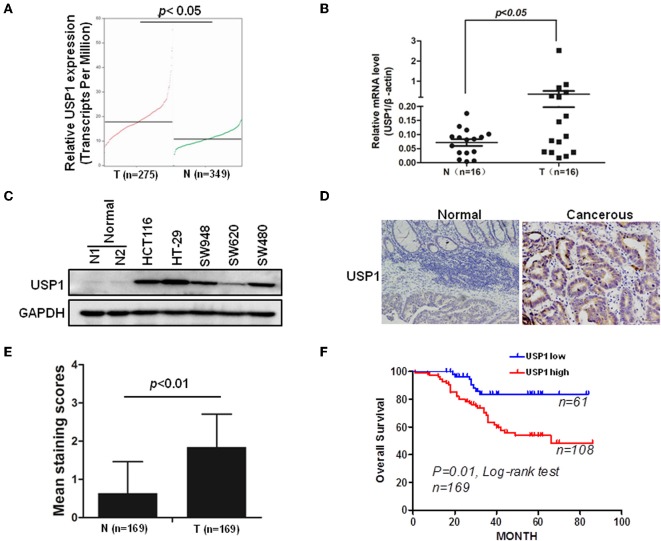
Ubiquitin specific protease (USP1) expression is increased in colorectal cancer and predicts a poor prognosis of patients with colorectal cancer. (A) The expression level of USP1 in colorectal adenocarcinoma (COAD) was analyzed by Gene Expression Profiling Interactive Analysis (GEPIA), matched with public cancer database The Cancer Genome Atlas (TCGA) and The Genotype-Tissue Expression (GTEx) (http://gepia.cancer-pku.cn). N, normal; T, tumor. (B) Sixteen pairs of paracancerous and tumor tissues from colorectal cancer were collected and examined for USP1 expression by qRT-PCR. β-actin was used as an internal control. (C) Five colorectal cancer cell lines and two paracancerous tissues were lysed for immunoblotting against USP1. Glyceraldehyde-3-phosphate dehydrogenase (GAPDH) was used as an internal control. (D) Representative immunohistochemical fields of human colorectal cancer tissues stained with an anti-USP1 antibody. (E) Statistical analysis of human colorectal cancer tissue array (n = 169) stained with an anti-USP1 antibody. Immunostaining scores (mean ± SD) for USP1 in paracancerous (N) and cancerous (T) tissues were summarized. (F) The Kaplan–Meier survival curves of colorectal cancer patients. There was a significant difference between these with tumors expressing high and low levels of USP1.